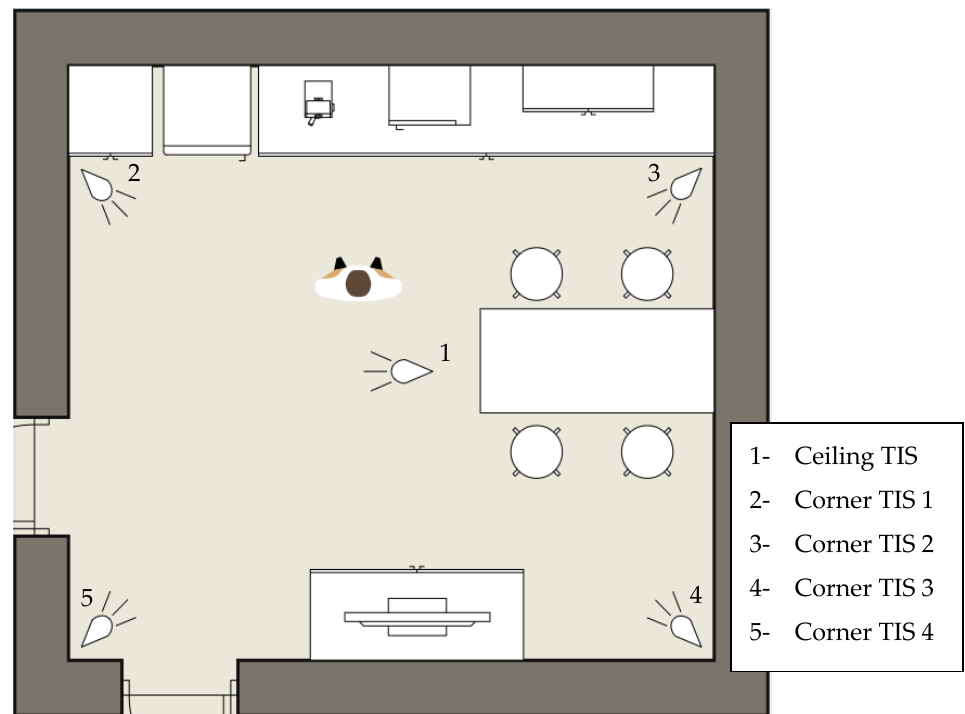
Figure 3. Top-down visualisation of the smart kitchen with labelled locations of each thermopile infrared sensors (TIS).